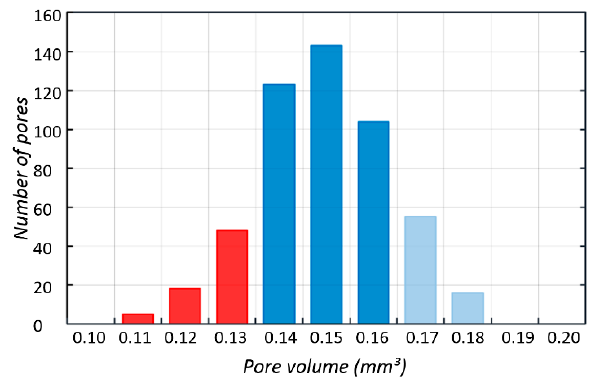
Figure 8. Histogram of pore volume distribution obtained using Avizo 8.0.